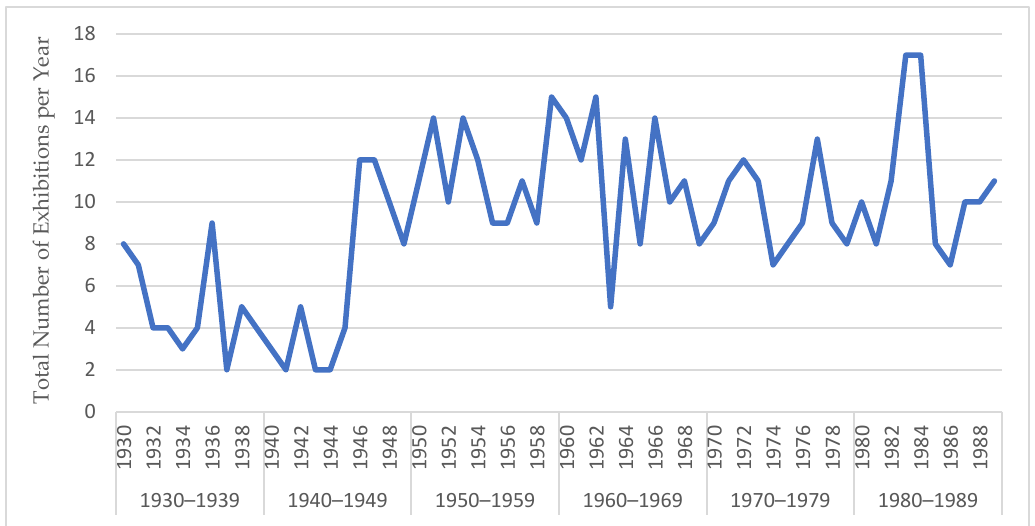
Figure 1. Number of museum exhibitions per year in three Dutch museums.